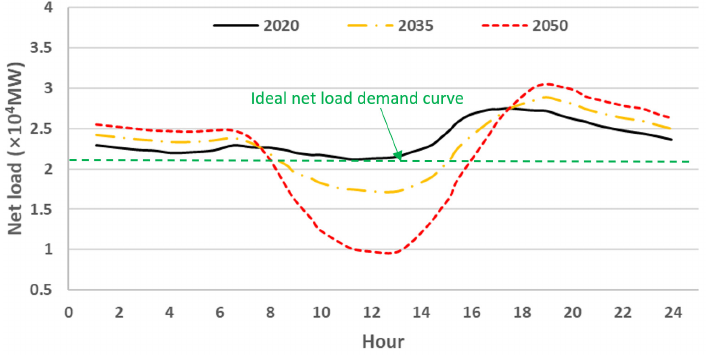
Figure 2. Duck curve of North China in 2020, 2035, and 2050 for a typical summer day [30].